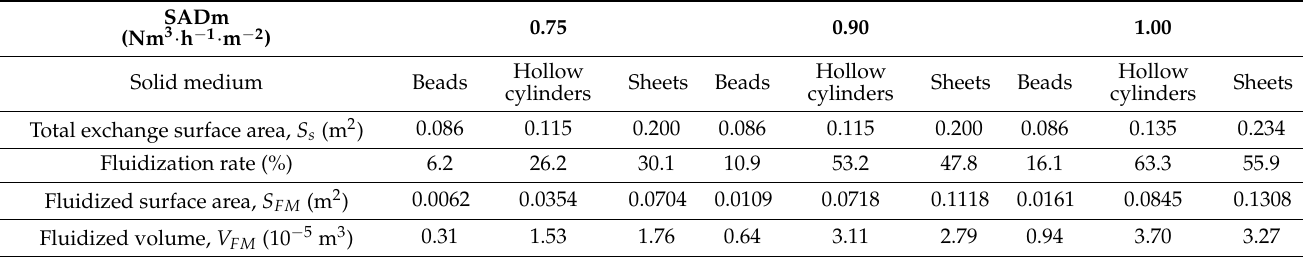
Table 6. Solid media properties in the ALMBR, under different air